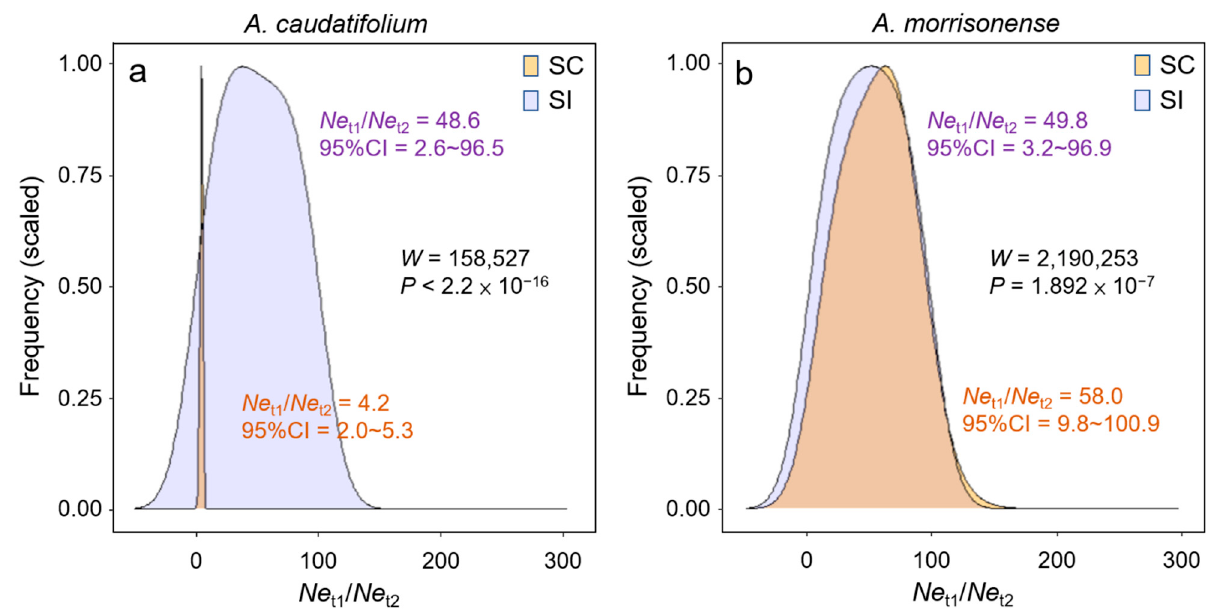
Figure 6. Scaled density plots of the estimated ratio of population size change ( Ne t1 / Ne t2 ) in ( a ) Acer caudatifolium and ( b ) A. morrisonense under the secondary-contact (SC) and strict-isolation (SI) sce- narios. The significance of differences between simulations of different scenarios was conducted by Mann–Whitney U Test.